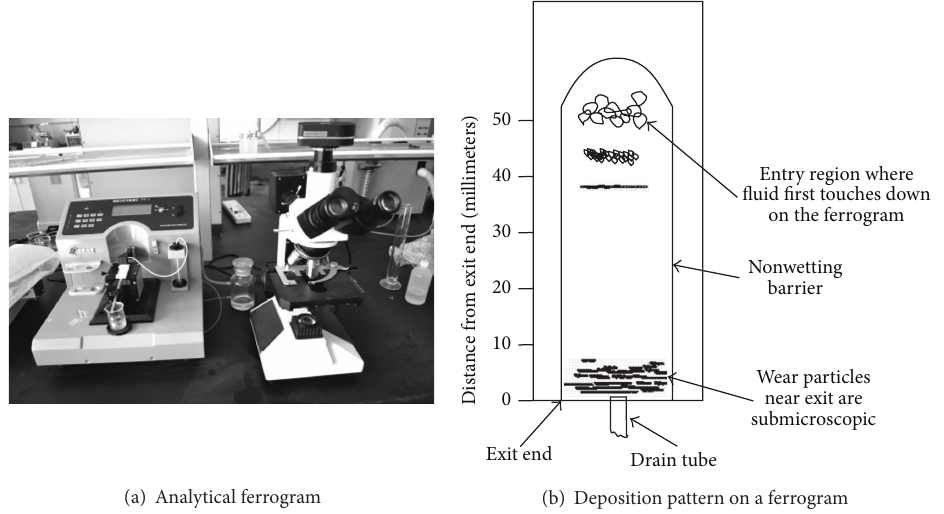
Figure 1: Picture of analytical ferrogram and its schematic